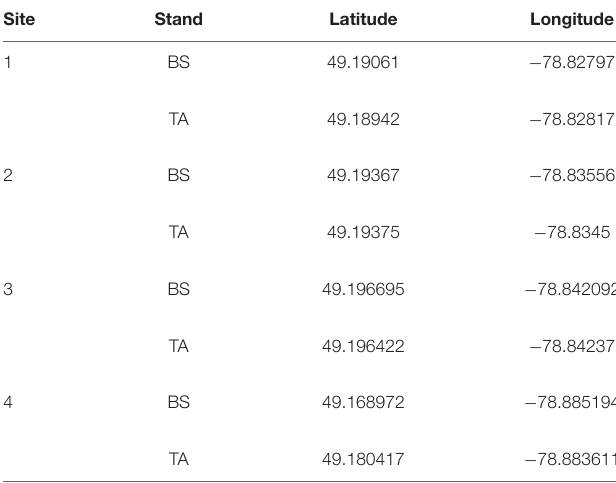
TABLE 1 | GPS coordinates of